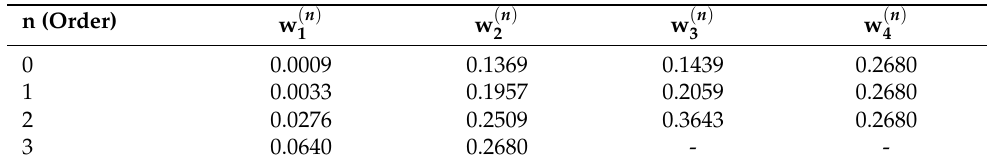
Table 1. The first four order of w ( n ) to derive ˆ z n ( ν ) with f max ≈ 2047 Hz, (cid:101) = 1/40, R Q = 0.16 m and c = 343